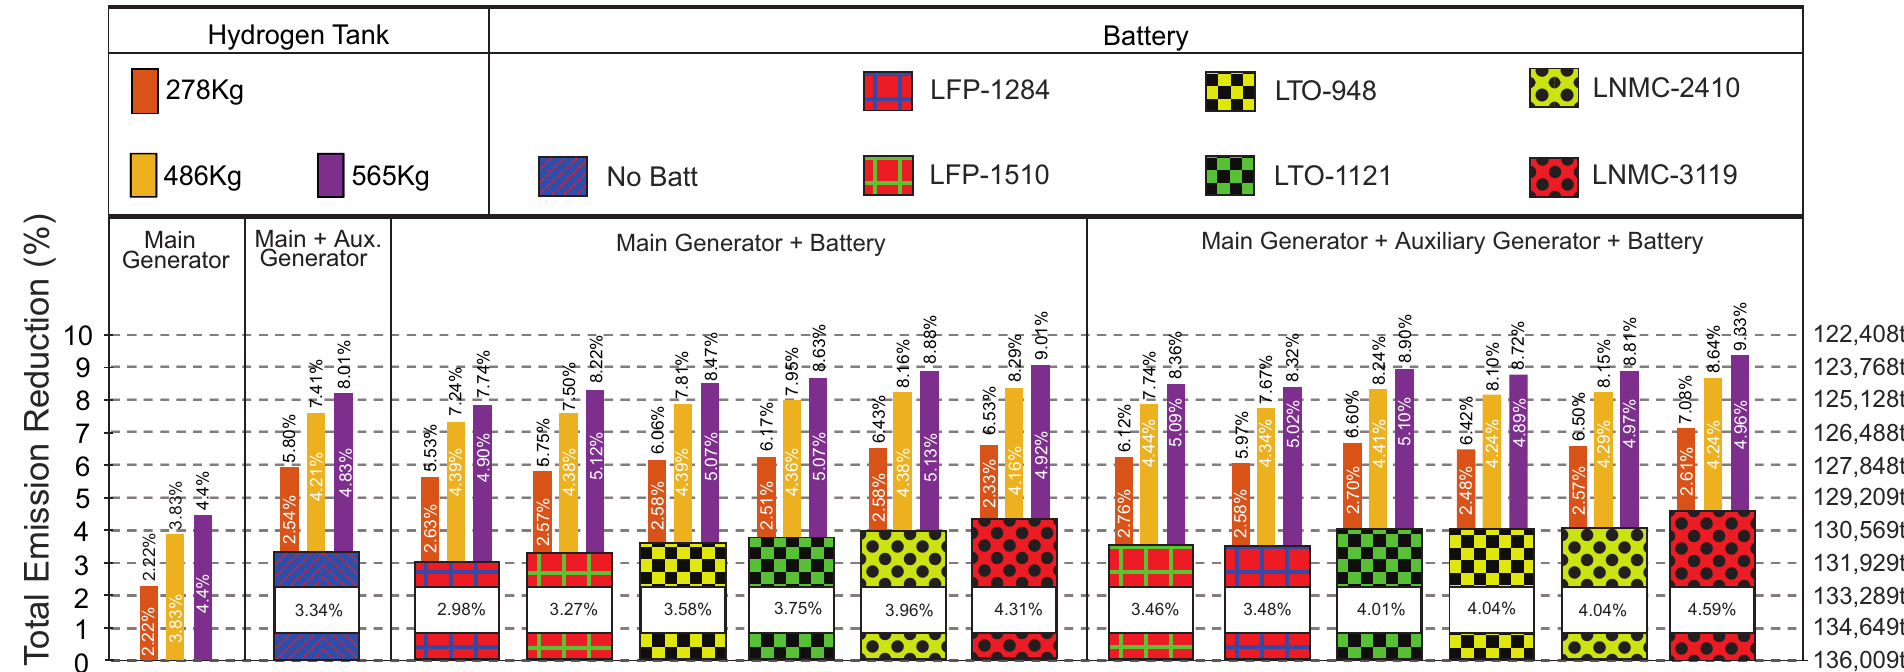
Figure 10. Total emission reduction results obtained from the configurations operating at normal